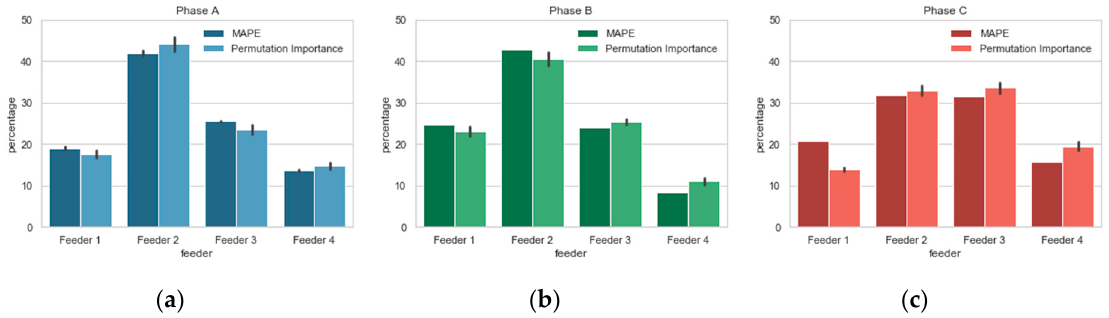
Figure 9. Percent Harmonic impact factor grouped by feeder for phases ( a ) A, ( b ) B and ( c ) C.